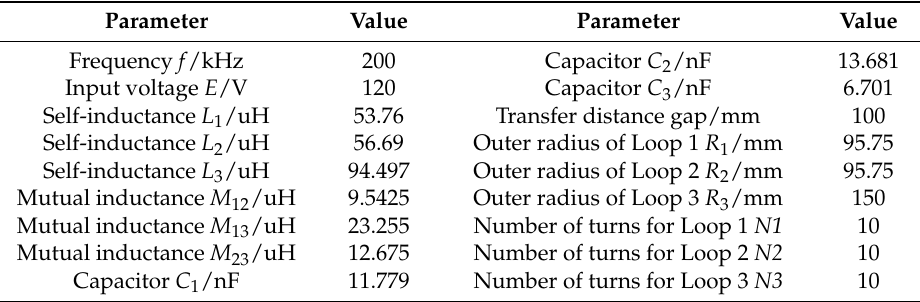
Table 1. Parameter values for 3-coil system.